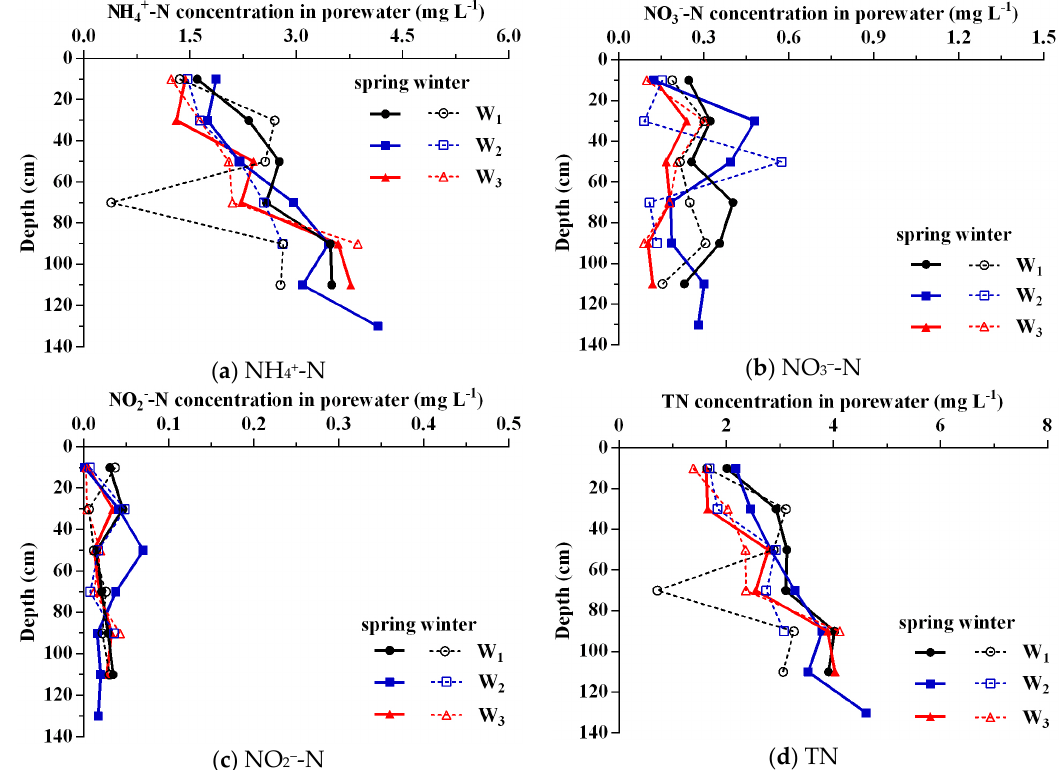
Figure 4. Vertical profiles of nitrogen in the porewater of the hyporheic zone at the west sites in Lake Taihu during spring and winter 2016.